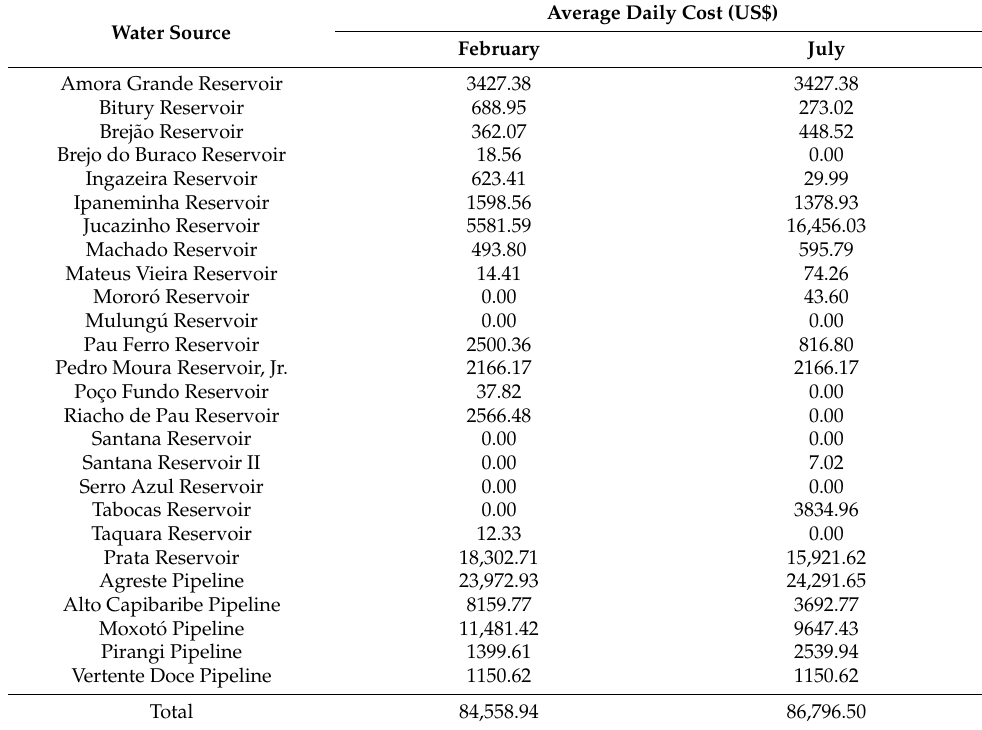
Table 1. Average daily cost per water source in February and